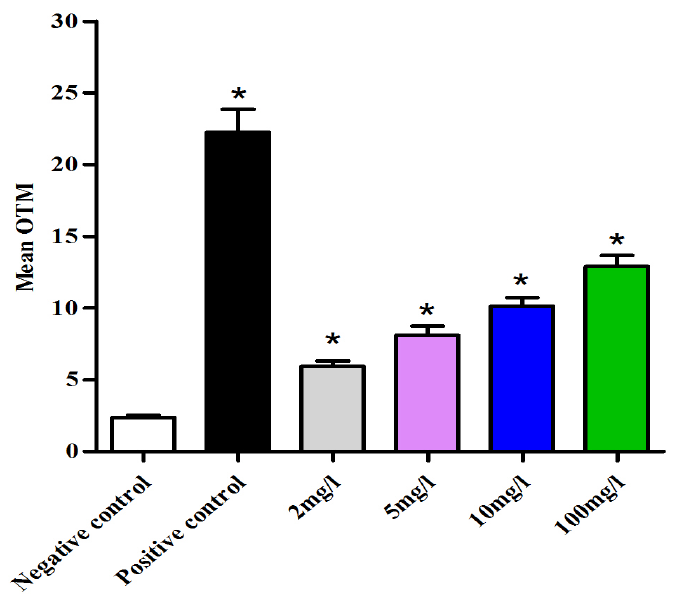
O ENPs on follicular cells by comet assay. * p ≤ e 2